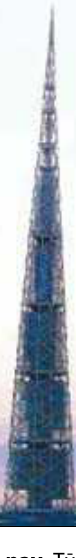
Fig. 7. Millenium tower in tokyo bay, 1989. architect Sir N. Foster